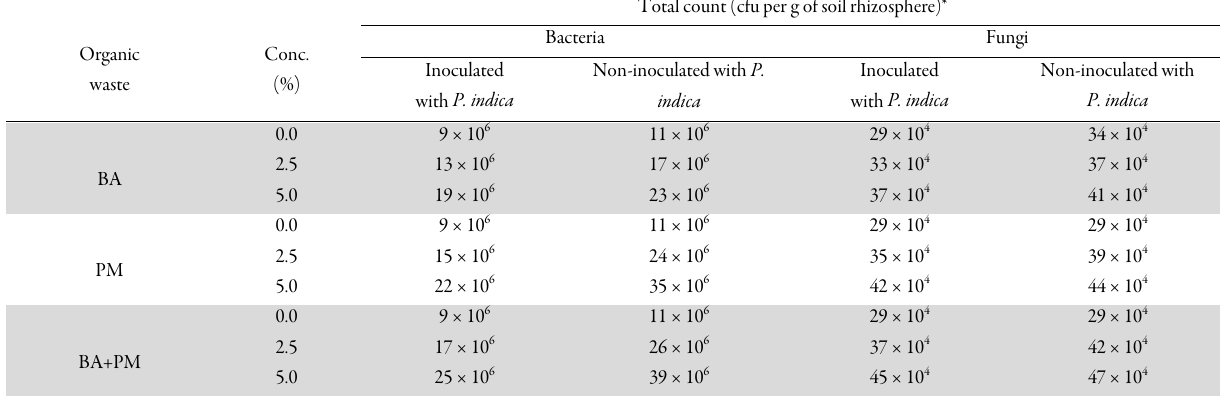
Table 5. Effect of organic wastes as soil amendments on bacterial and fungal population in rhizosphere of cucumber plants grown in non-autoclaved soil after inoculation of seeds with Pi under greenhouse conditions Total count (cfu per g of soil rhizosphere)* Bacteria Fungi Conc. Organic Inoculated (%) waste with P.